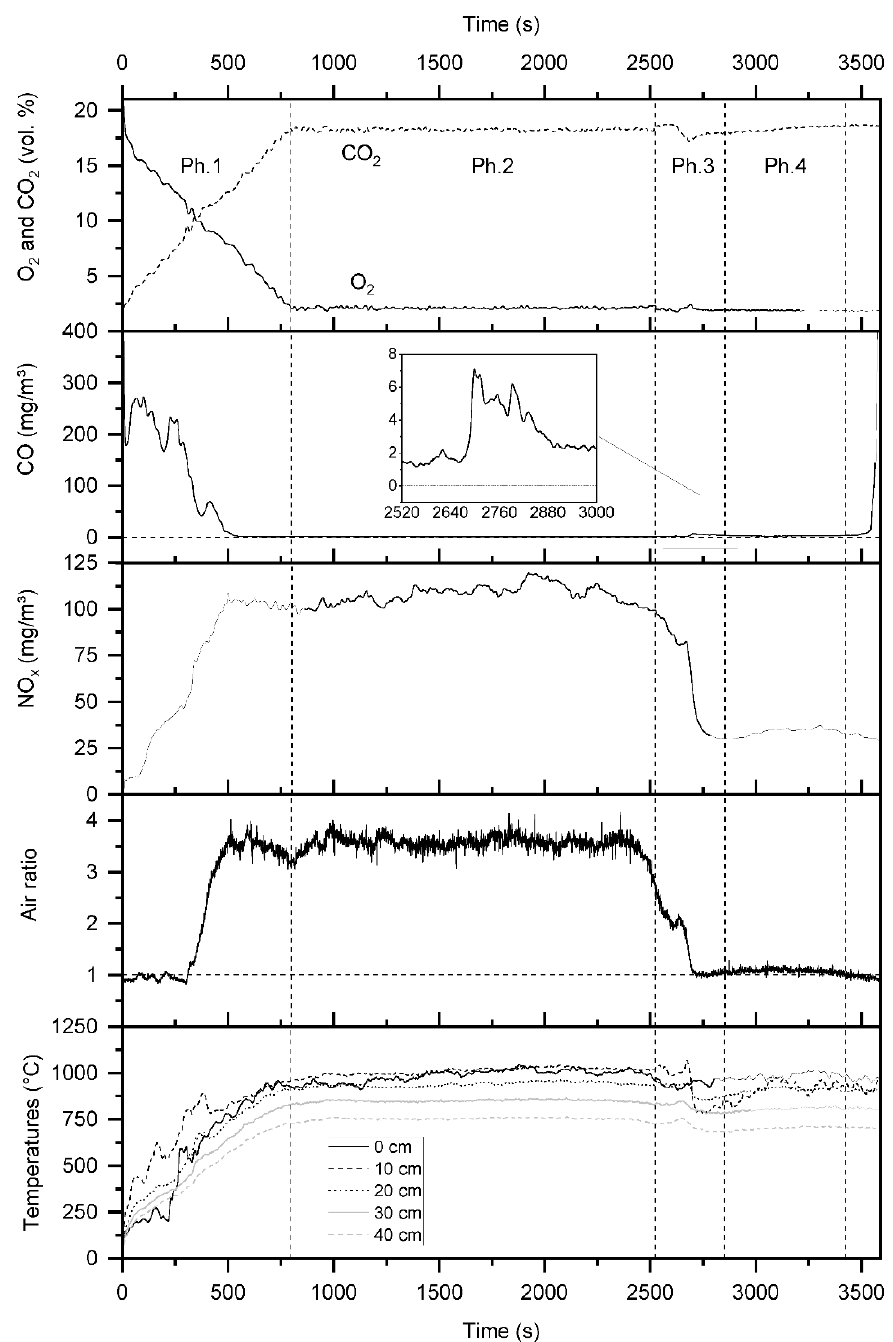
Figure 2. O 2 , CO 2 , CO and NO x content into standardized 13 vol. % O 2 content in dry flue gas (STP), air ratio (secondary air to primary air) and temperatures (height over burner nozzle) for a complete combustion cycle without auto-switch-off at the end of combustion (Exp. 2); details of the CO emissions during the transition phase was given in the box (time after the start of the phase).